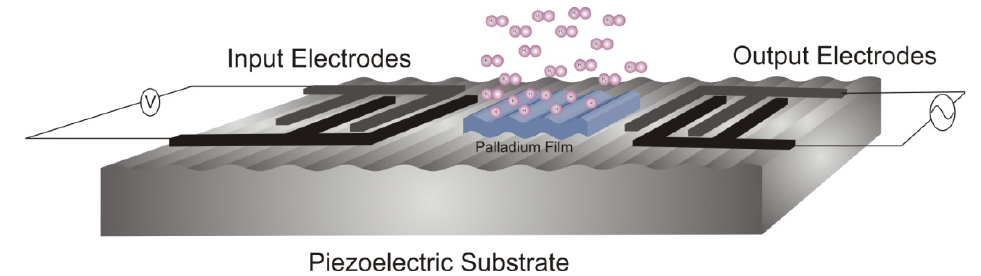
Figure 1. Layout of the SAW hydrogen